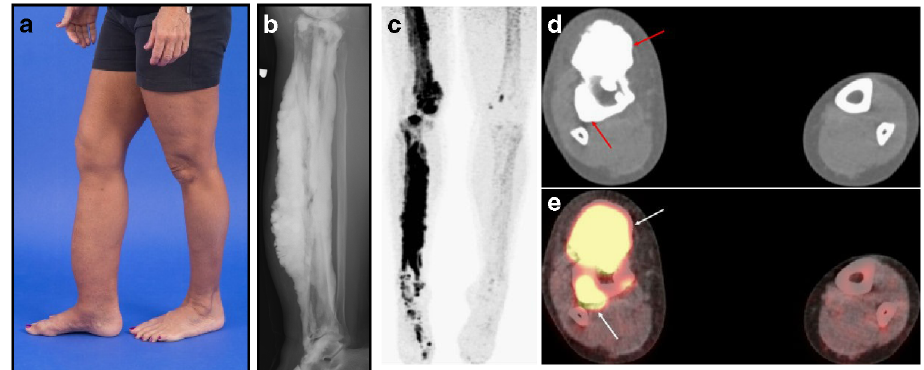
Fig. 1 Clinical fi ndings in melorheostosis. a Clinical appearance of Melo-10 with melorheostosis of right lower extremity. Note irregular thickening of the right leg. The affected bone was found to harbor a MAP2K1 mutation. b Radiograph of the right tibia/ fi bula of Melo-10 with classic candle-wax appearance. c Maximal intensity projection (MIP) 18 F-NaF PET image of the lower extremities showing intensely increased 18 F-NaF activity in the bones of the right leg, primarily along the medial and distal femur, and along the tibia extending into the foot. d , e Axial CT and fused 18 F-NaF PET/CT images at the level of mid-calf demonstrating dense cortical bone formation in the anterior and posterior aspect of the right tibia (red arrows in d with corresponding abnormally increased 18 F-NaF uptake (white arrows, in e